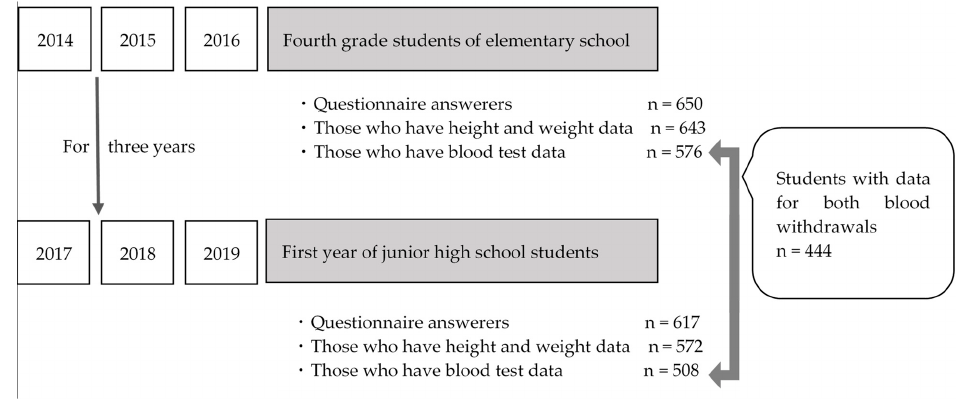
Table 1. Demographic characteristics of the study participants when they were in the fourth grade of elementary school.